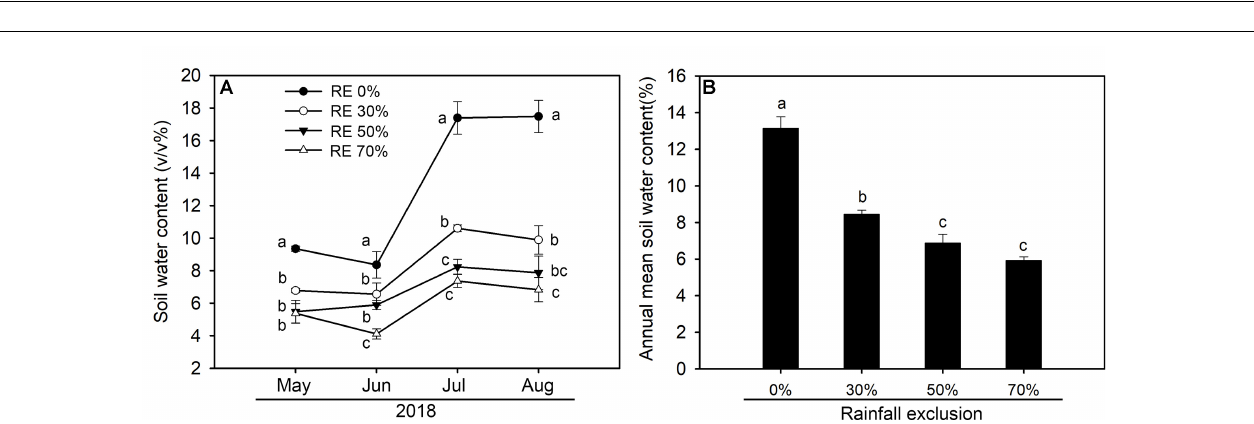
FIGURE 2 | Seasonal dynamics of soil water content (V/V%) (A) and seasonal mean soil water content (B) at 0–10 cm depth of each rainfall exclusion treatment in 2018. RE0%, 0% rainfall exclusion; RE30%, 30% rainfall exclusion; RE50%, 50% rainfall exclusion; RE70%, 70% rainfall exclusion. Different lowercase letters indicate significant differences ( P < 0.05) among the rainfall exclusion treatments. Data are reported as mean ± 1 SE ( n = 4).